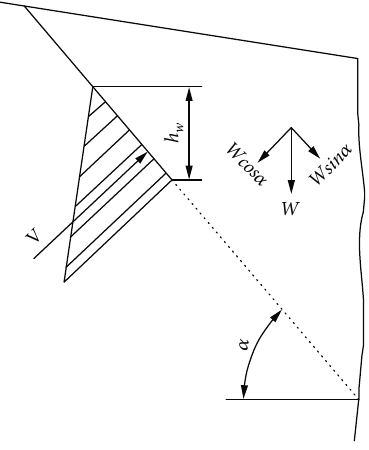
Figure 1: A typical slip-type perilous rock model.